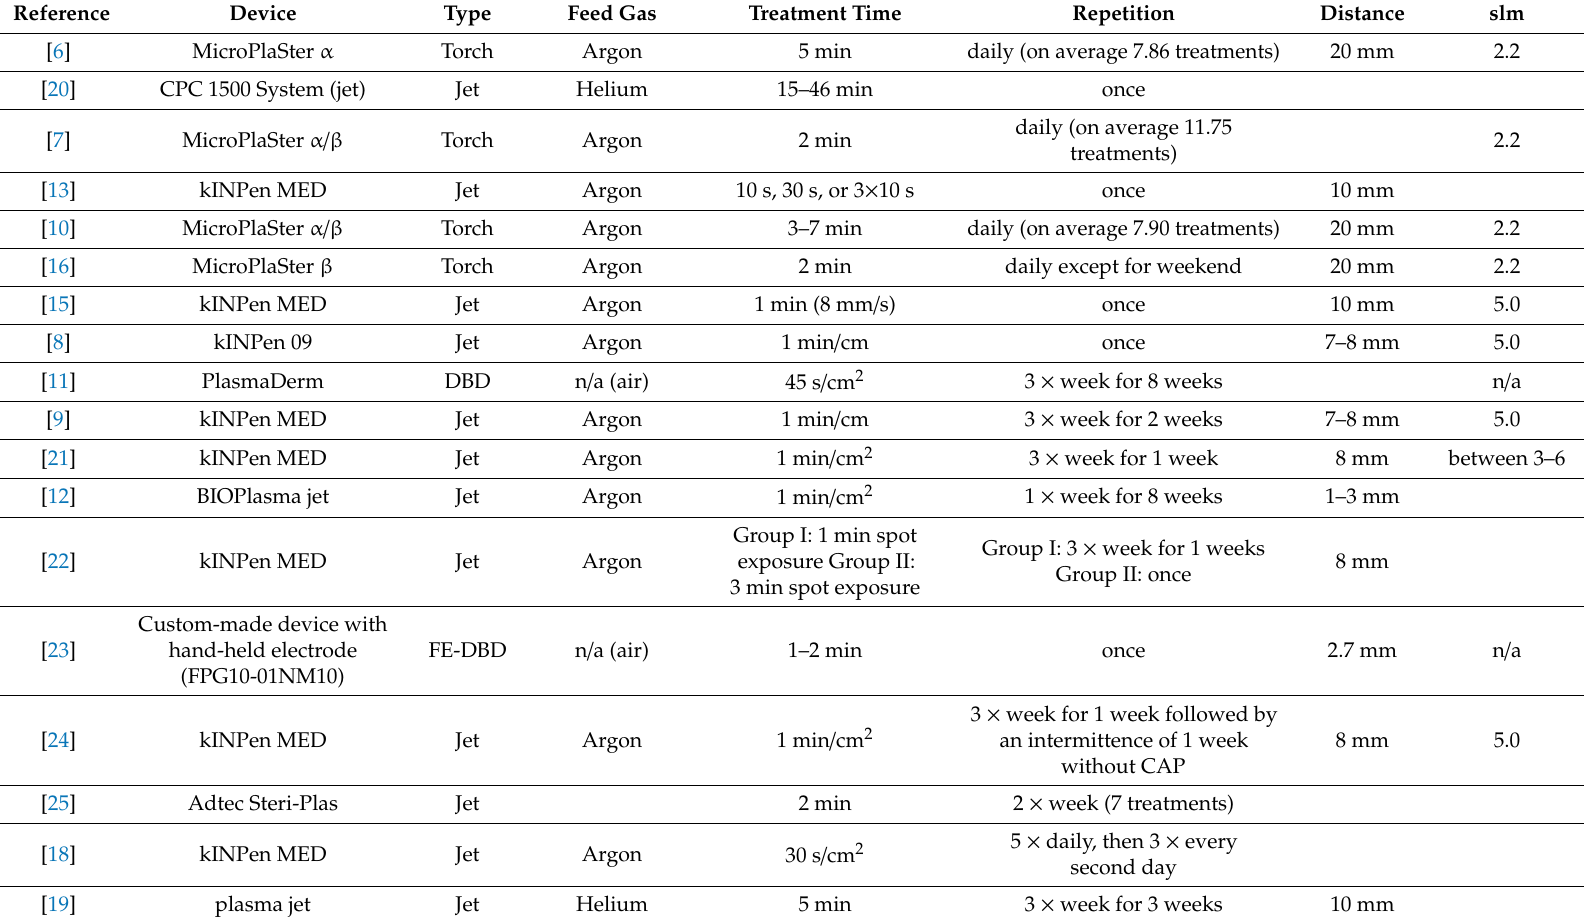
Table 2. Frequently reported treatment parameters in clinical pilot studies and case reports of CAP application for treatment of chronic and acute wounds, as well as (pre-) cancerous